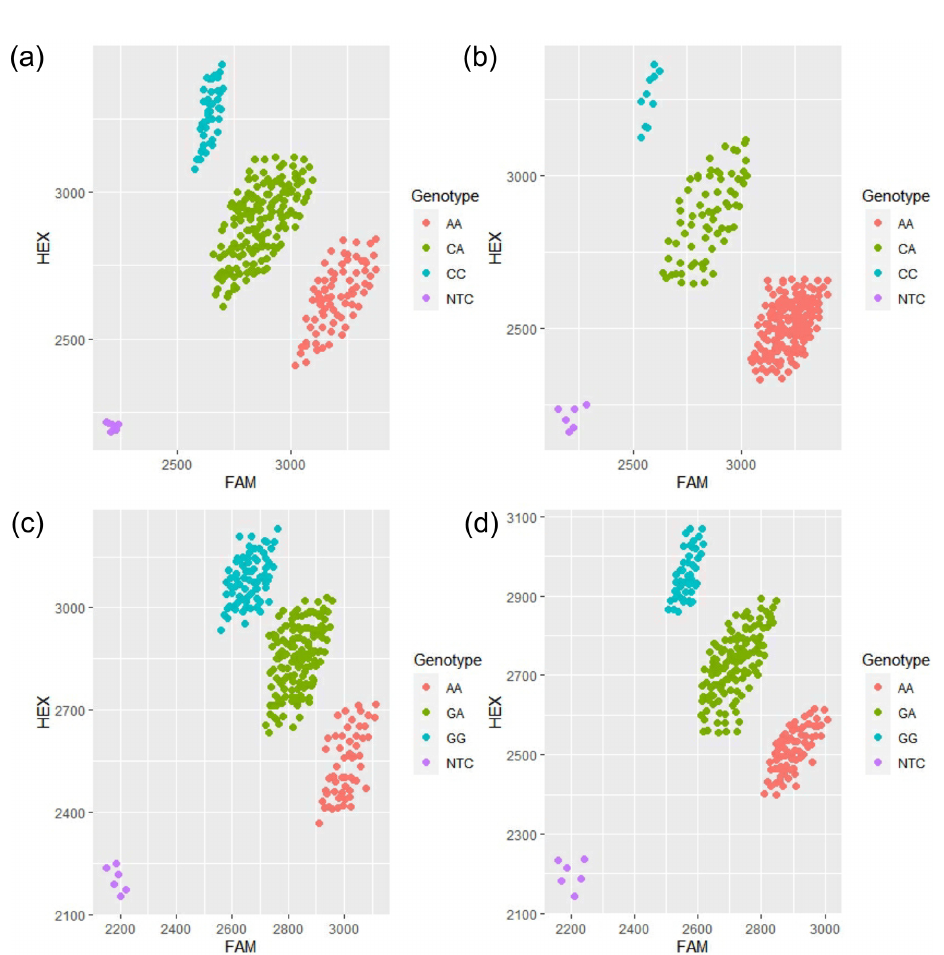
Figure 2. Principal component analysis (PCA) typing diagram of each mutation site of the MLPH gene. (a) PCA graph of c.1807C > A for Korean quail; (b) PCA graph of c.1807C > A for Beijing white quail; (c) PCA graph of c.2129G > A for Korean quail; (d) PCA graph of c.2129G > A for Beijing white